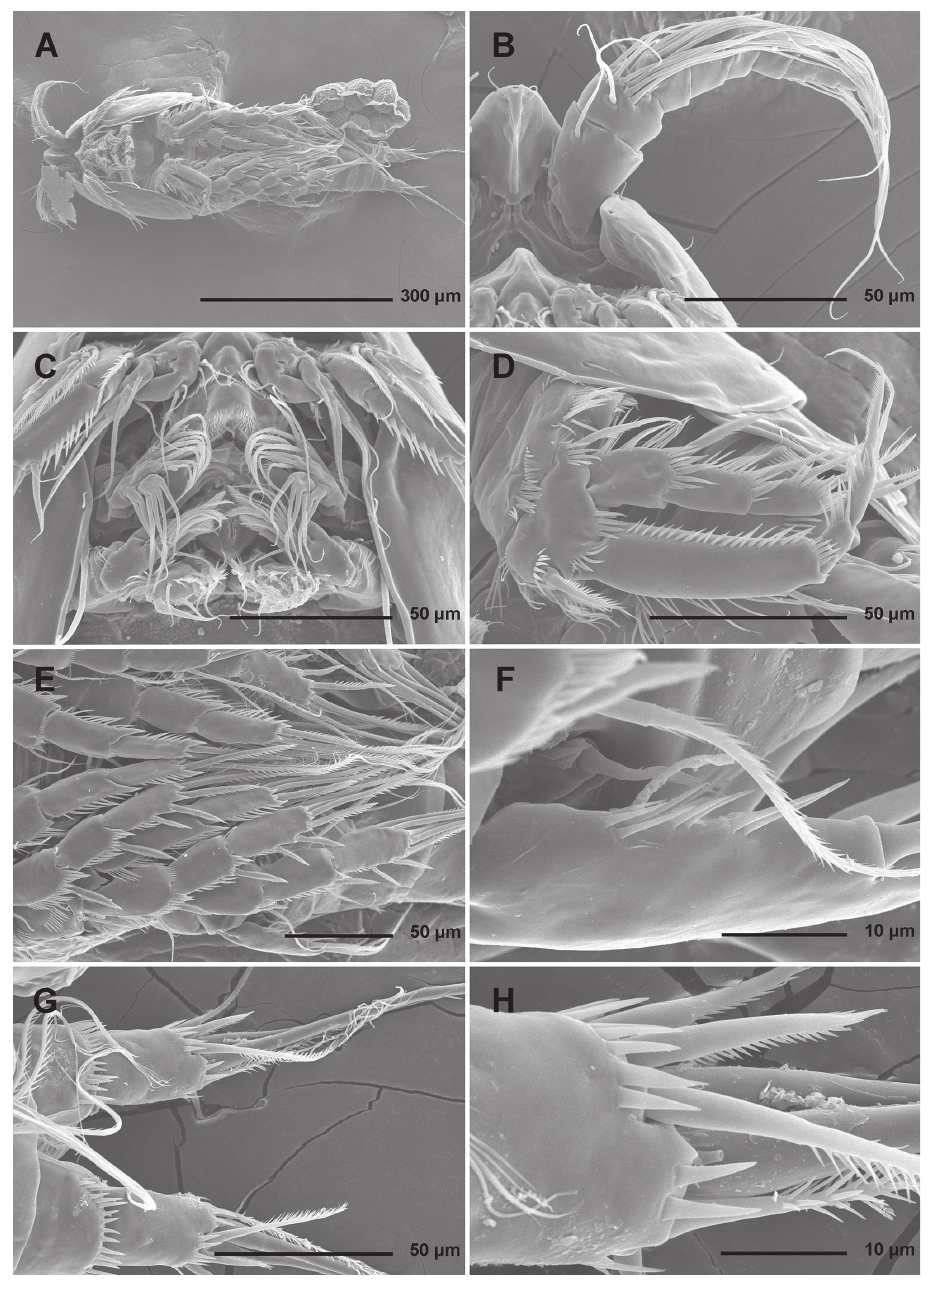
Figure 2. Stenhelia pubescens Chislenko, 1978, scanning electron micrographs, ovigerous female 2: A habitus, ventral B rostrum and left antennula, ventral C mouth appendages, ventral D first leg, ante- rior E second, third, and fourth legs, anterior F exopod of fifth leg and sixth leg, ventral G anal somite and caudal rami, ventral H posterior part of left caudal ramus,